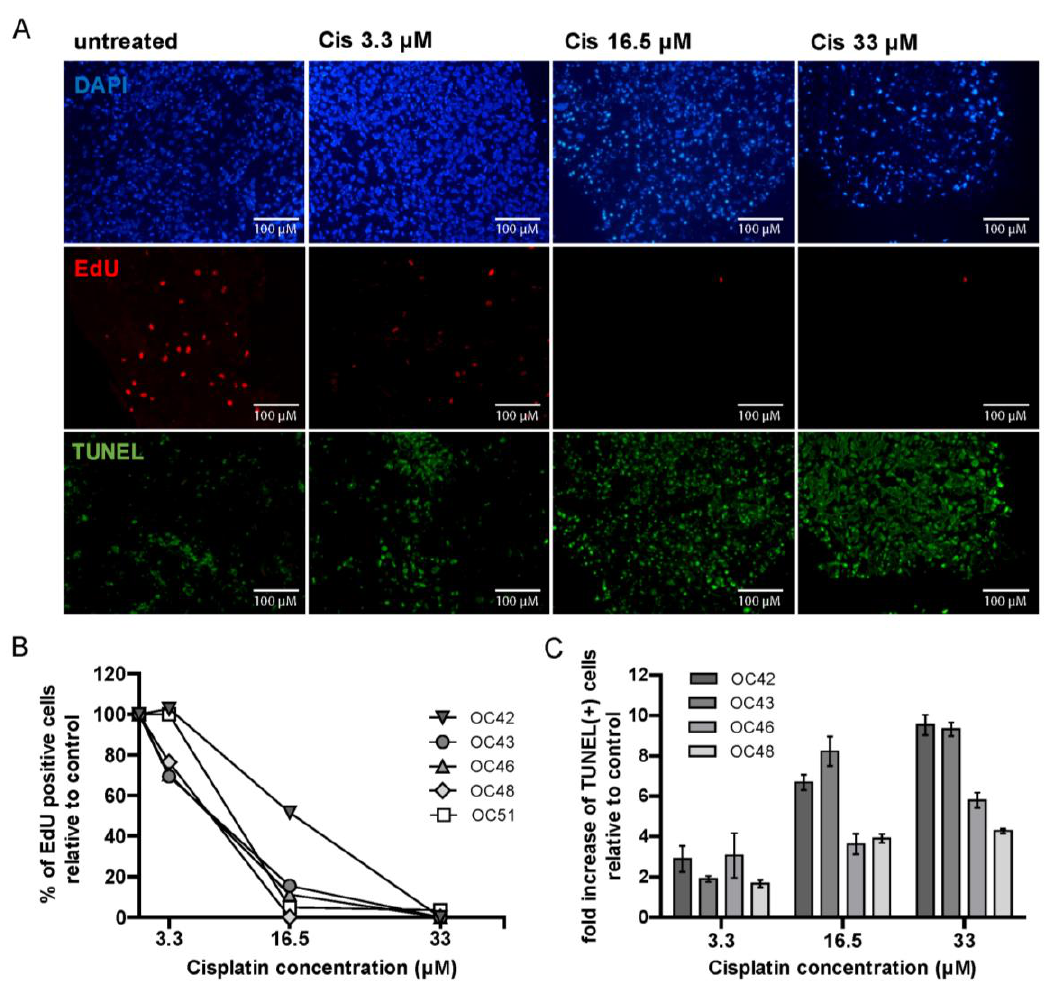
Figure 6. HNSCC tumor slices show heterogeneous response to cisplatin. ( A ) Representative microscopy images of a tumor sample treated with increasing concentrations of cisplatin. DAPI is shown in blue, EdU in red and TUNEL in green. ( B ) Quantification of EdU positive cells upon treatment with increasing concentrations of cisplatin, relative to the untreated control. Each point represents the mean value of ≥ 3 FoV per sample. For clarity of the graph, SEM is not shown. ( C ) Quantification of TUNEL positive cells upon treatment with increasing concentrations of cisplatin relative to untreated control. Each bar represents the mean value of ≥ 4 FoV per sample, and error bars indicate SEM. Cis = cisplatin.